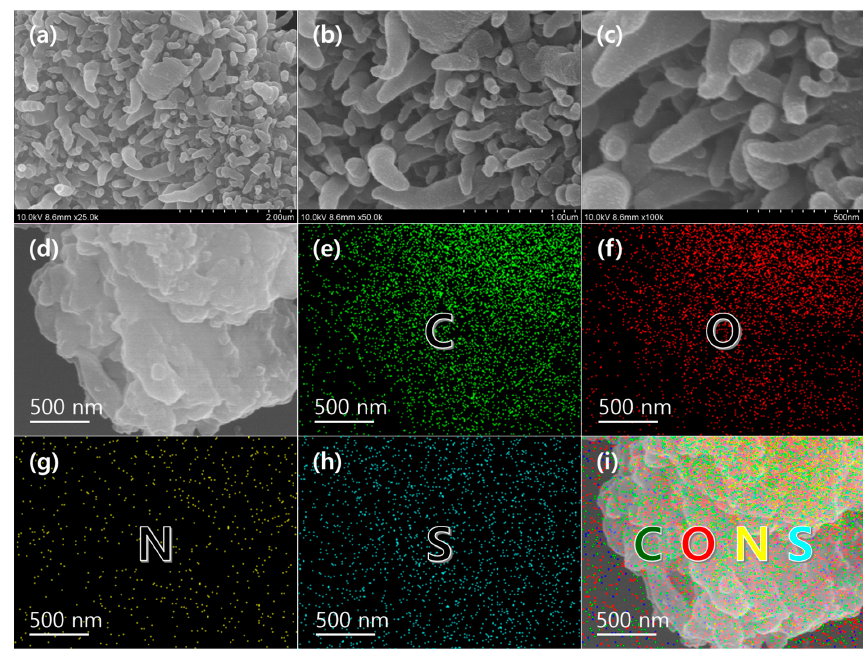
Figure 1. ( a – d ) FESEM images taken at various magnifications of the prepared ATC and the corre- sponding ( e ) carbon, ( f ) oxygen, ( g ) nitrogen, ( h ) sulfur, and ( i ) overlapping elemental maps of the presented elementals.